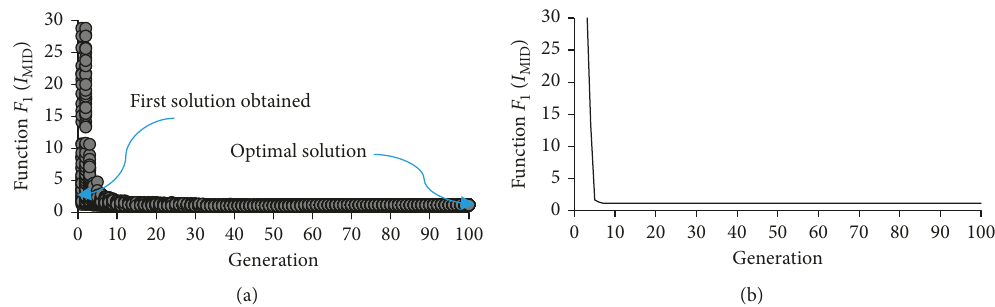
Figure 7: Behavior of objective function F 1 for model RC-3: (a) all individuals per generation; (b) average values of objective per generation.